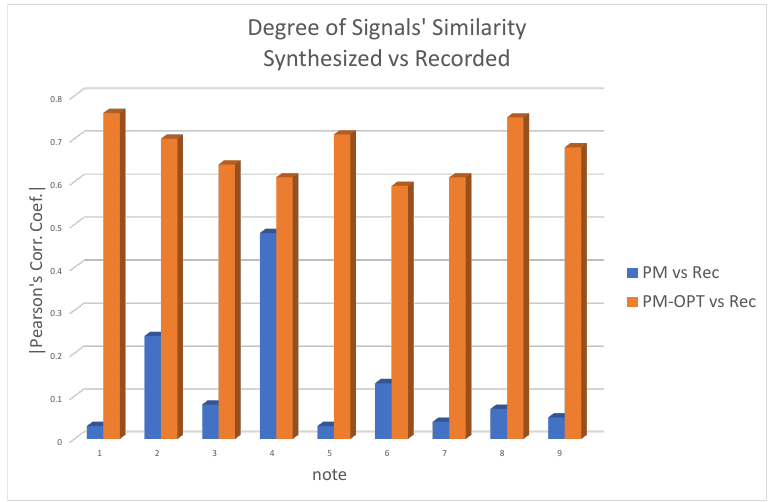
Figure 3. The degree of similarity (calculated by the absolute Pearson’s correlation factor) between the synthesized and recorded signals in various notes for PM (blue) and PM with optimal correction factors